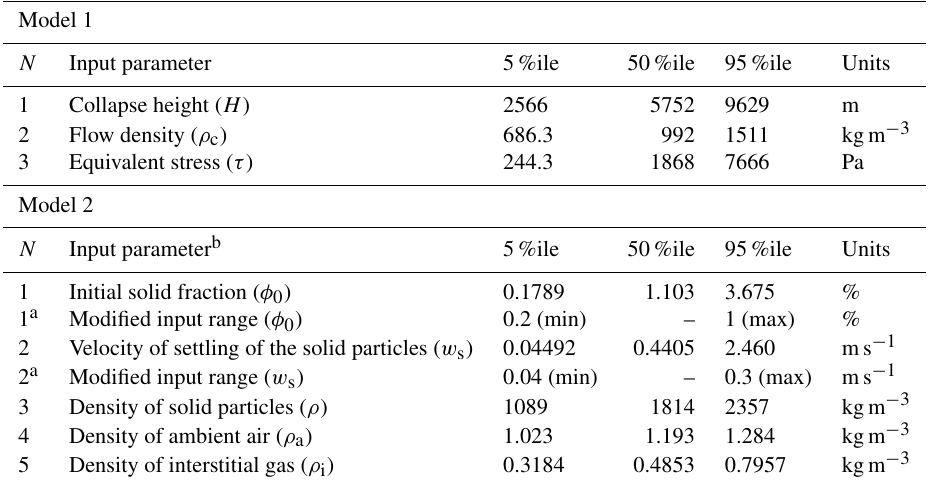
Table 1. Elicitation solutions for model 1 and model 2 parameters, and modified input range of model 2b based on mass discharge rate (MDR) modeling and Sauter diameter of analogs (see Sect. 3.2). The reported values express the percentiles of the probability distribution obtained by equal weights pooling of experts’ judgments (also called the solution decision maker